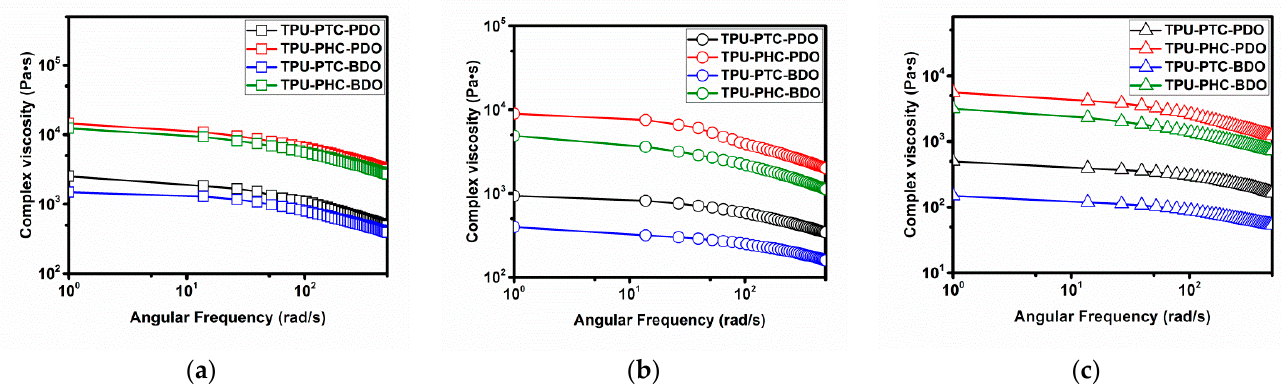
Figure 10. TPU rheology testing (complex viscosity vs. angular frequency) at ( a ) 180 °C, ( b ) 190 °C, and ( c ) 200 °C.